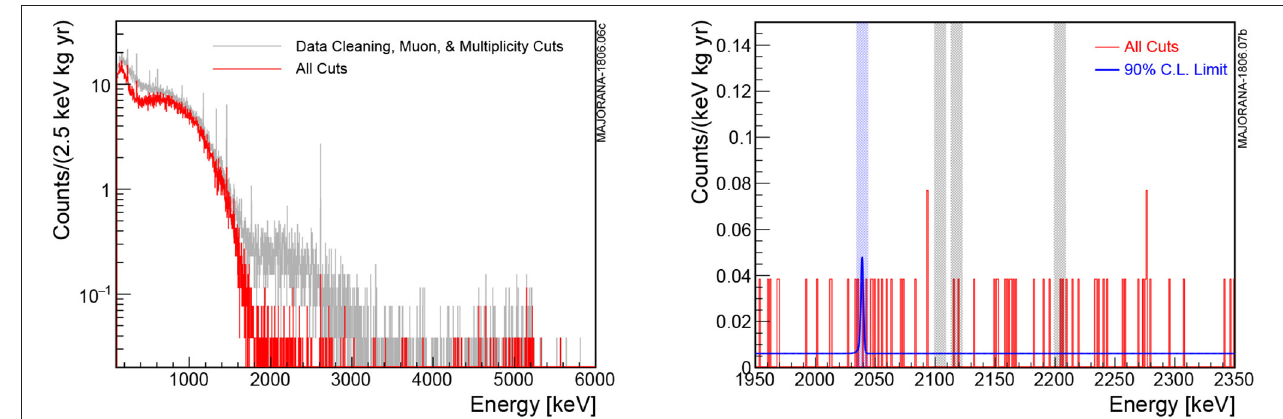
FIGURE 6 | (Left) The whole spectrum from the M AJORANA D EMONSTRATOR from 26 kg-yr of exposure. (Right) The specrum near the Q ββ for Ge at 2,038 keV [46]. Figures courtesy of the M AJORANA Collaboration. exposure are shown in Figure 6 . The energy resolution, 2.5 keV FWHM at Q ββ , is the best achieved of any ββ experiment.